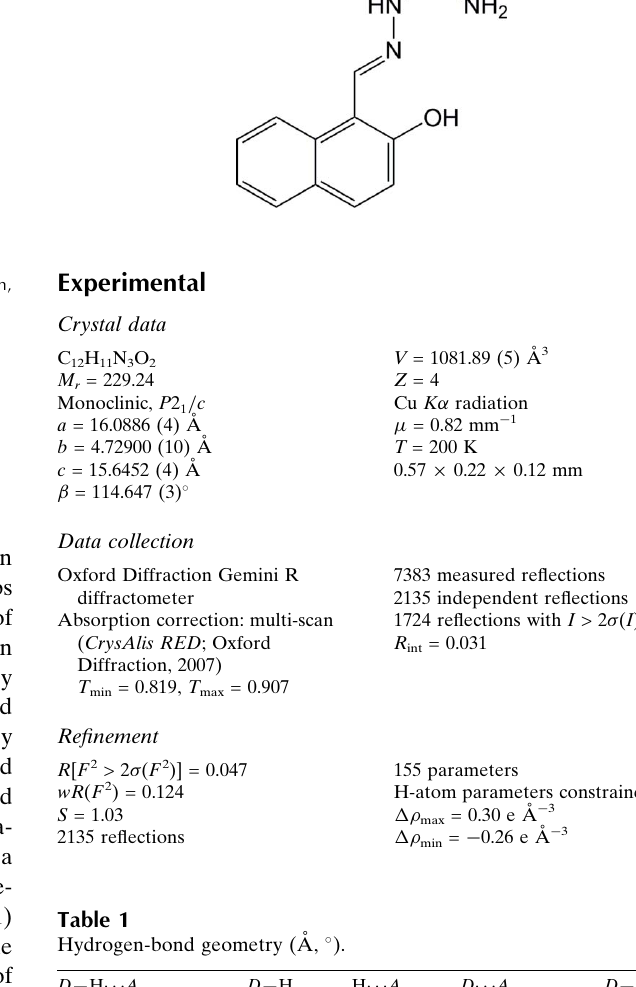
Hydrogen-bond geometry (A˚ , (cid:1) ). D —H (cid:3)(cid:3)(cid:3) A